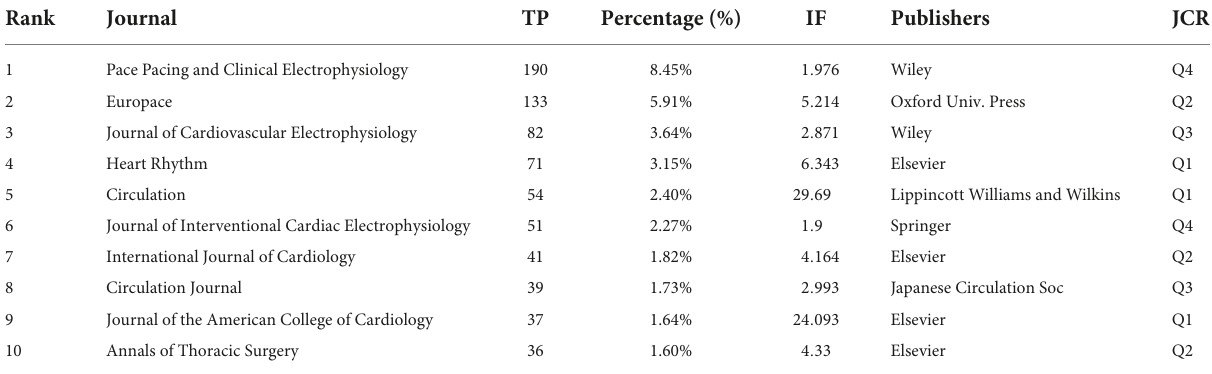
TABLE 4 The top 10 productive journals of sick sinus syndrome.